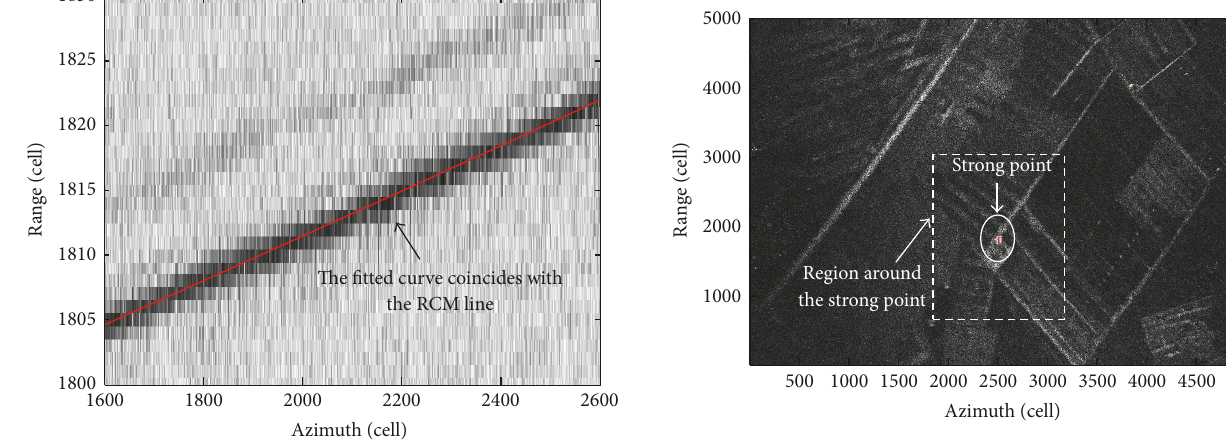
Figure5: Curvefitting result(monostaticSAR). Thefitted quadratic curve is coincident with the RCM line (100% for strong points in echo), which can be used to correct the RCM.